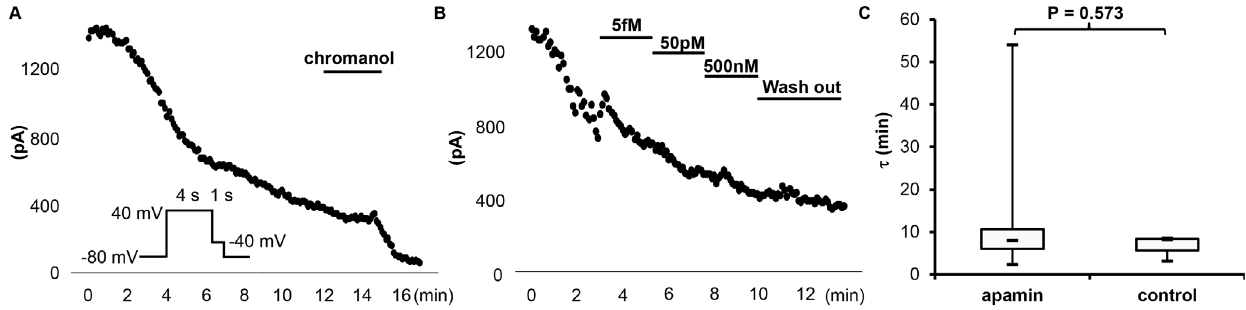
Figure 4. Effects of different concentrations of apamin on the rundown course of I Ks in transfected HEK 293 cells. (A) An observation experiment without apamin treatment showing time-dependent rundown, obtained with the pulse protocol shown in the inset with chromanol 293B at the end. (B) The representative time course of I Ks treated with different concentrations of apamin. (C) The time constant ( t ) of the rundown curve with (n=10) and without (n=3) apamin.